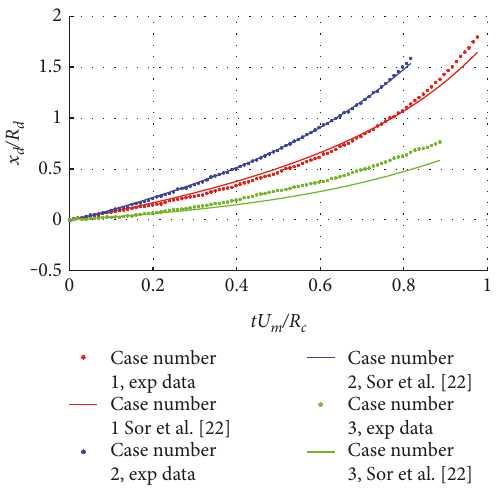
Figure 18: Comparison of the recorded droplet ’ s horizontal position for cases #1, #2, and #3 with those obtained by integrating the theoretical model presented by Sor et al. [22].